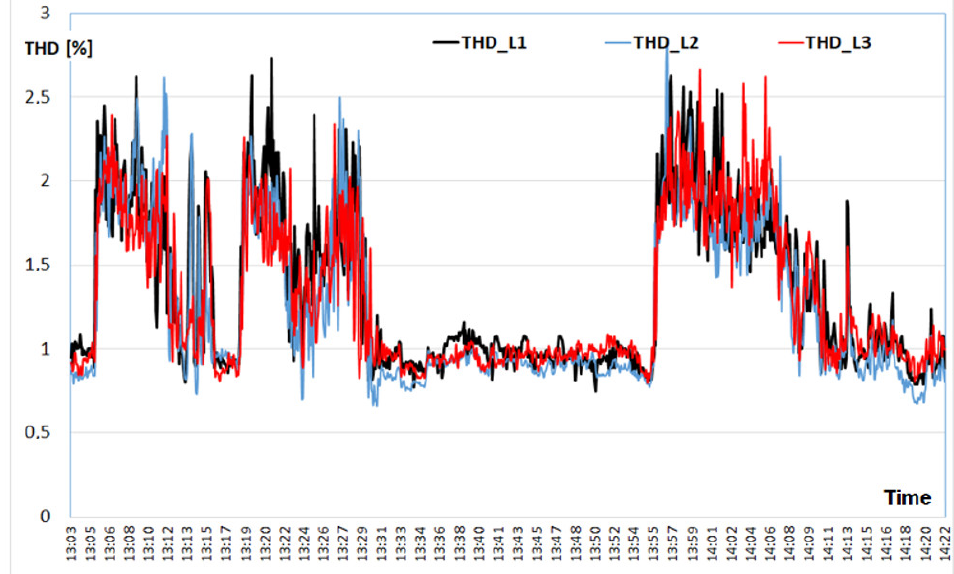
Figure 13. Changes in the total harmonic distortion THD recorded in three phases of the steelwork supply network during one melting in the arc furnace.